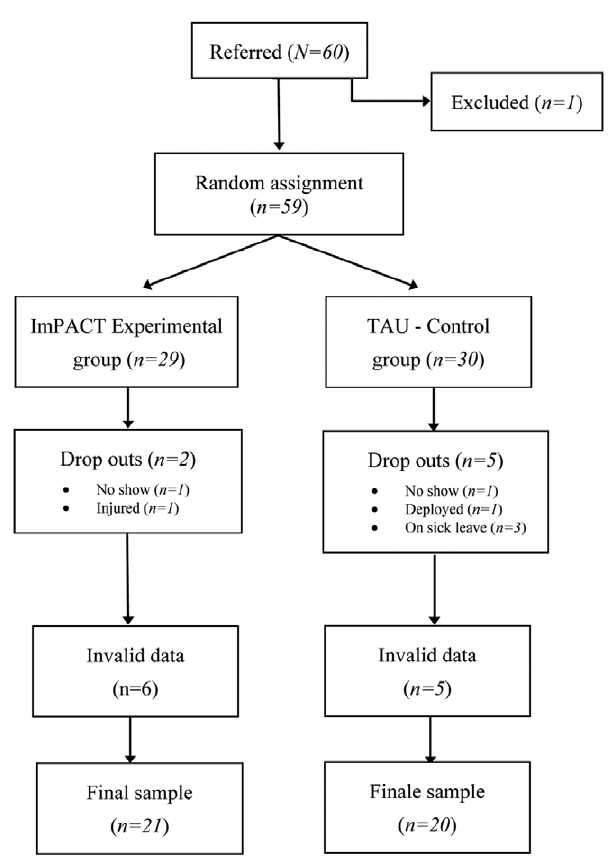
Figure 1. Participants’ flowchart.